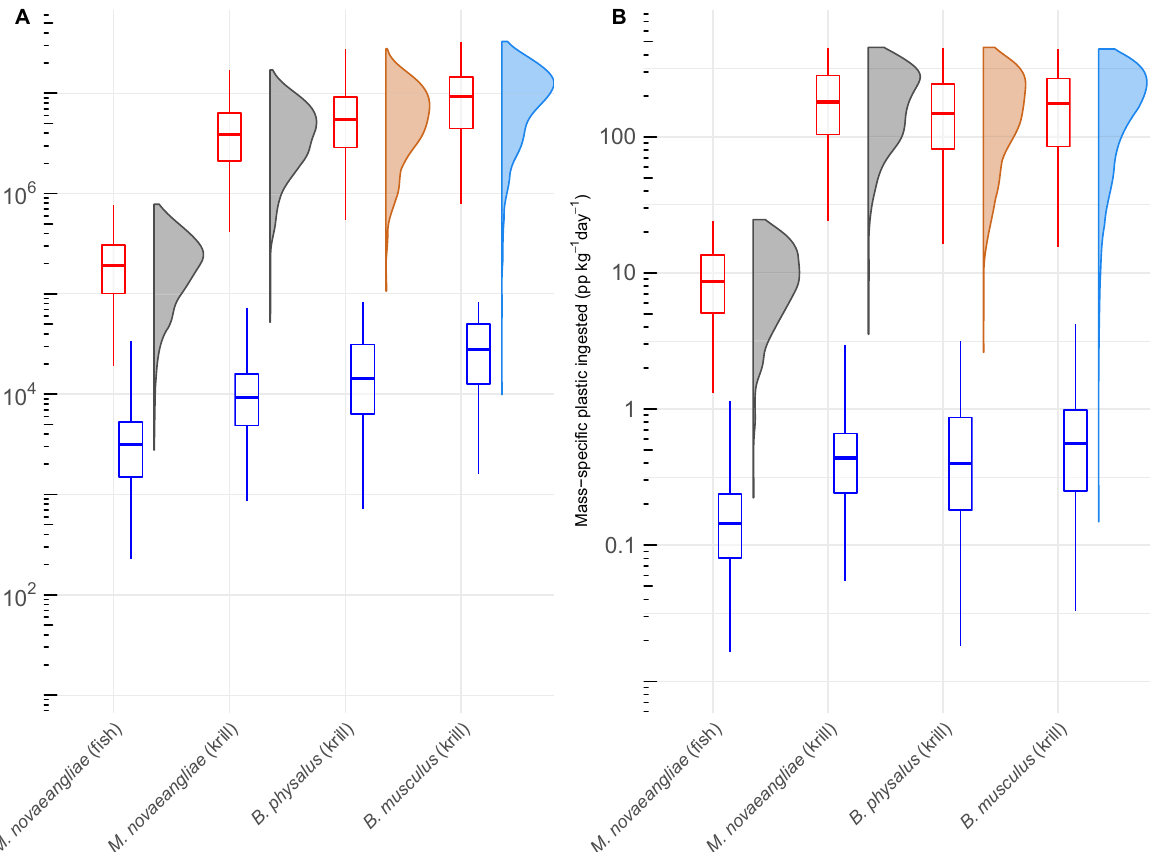
Fig.3|Theresultsofthemediumexposureriskscenariofor n =191biologically independent animals, broken up by prey type and species. Red boxplots represent microplastics consumed through prey while blue boxplots represent microplastics retained by fi ltration. Data are presented as median values and interquartile range (25 th − 75 th ), note the logarithmic scale. The density plots